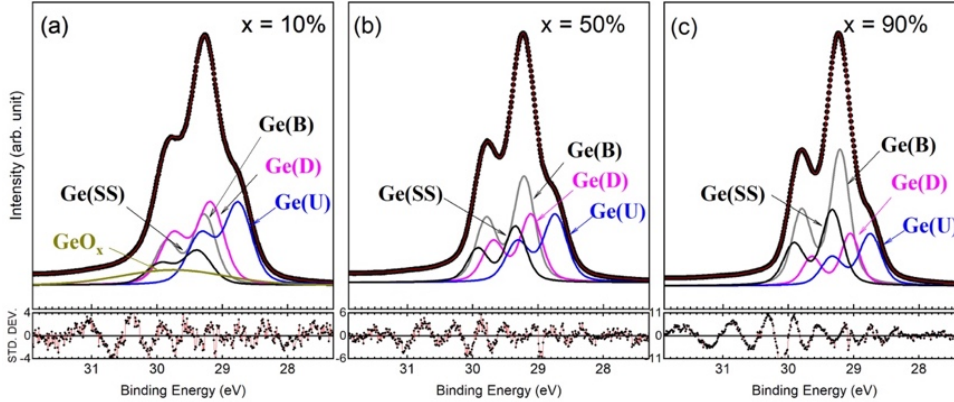
Figure 5. Fit to the Ge 3d core-level spectra for x = 10% ( a ), 50% ( b ), and 90% ( c ). Table 2. Fitted parameters of the Ge 3d and Si 2p core-level spectra in Figures 5 and 6. SCLS stands for the surface core-level shift.